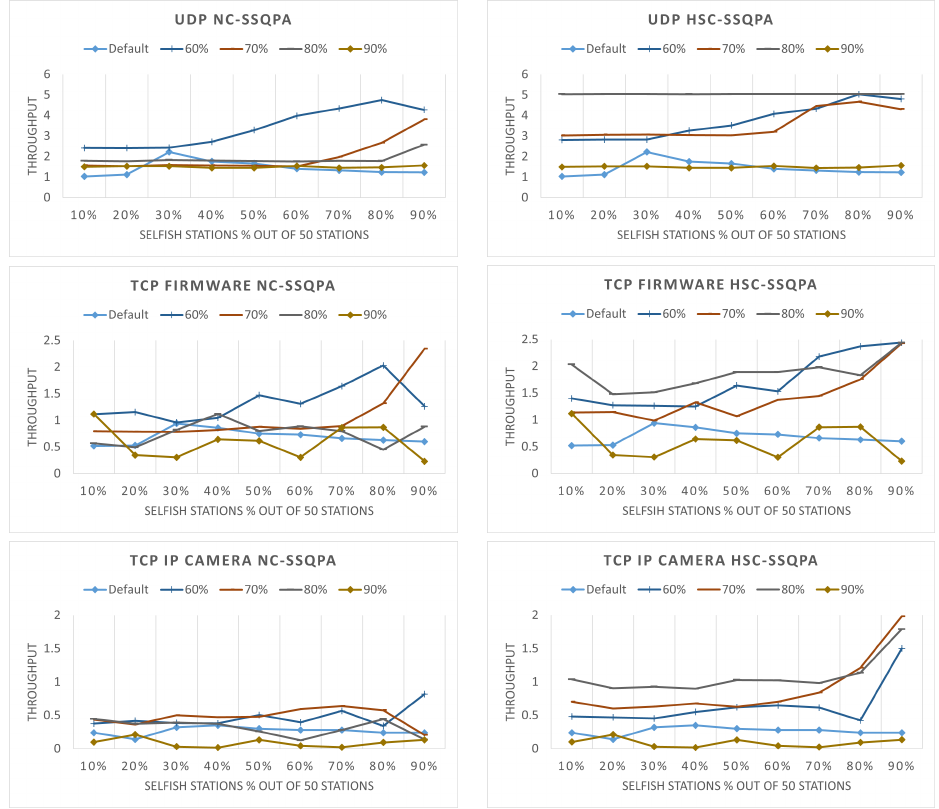
Figure 15. Network throughput (in Mbps) of not punished selfish stations for different percentage of detected stations: ( left ) NC-SSQPA, ( right )